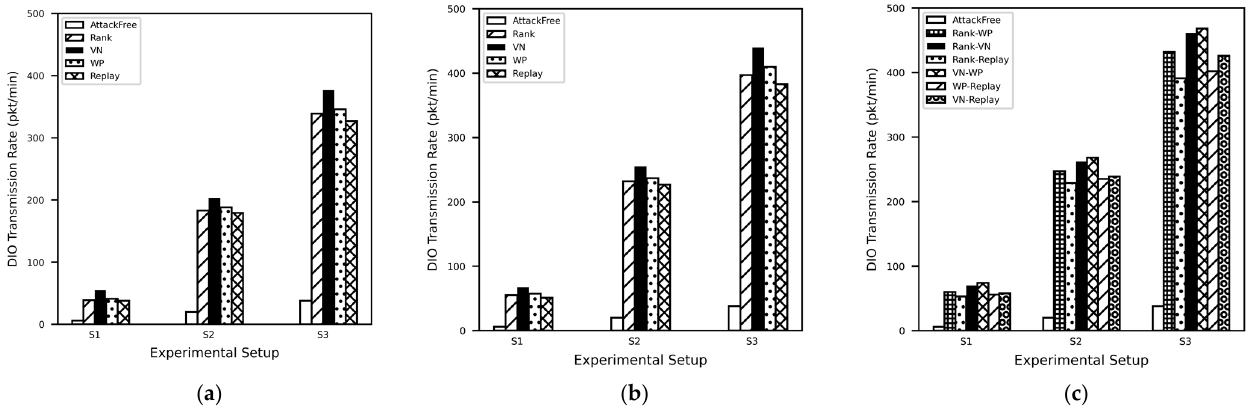
Figure 6. DIO Transmission Rate Results: ( a ) Single-Attack Scenario; ( b ) Composite-Attack Scenario; ( c ) Hybrid-Attack Scenario.